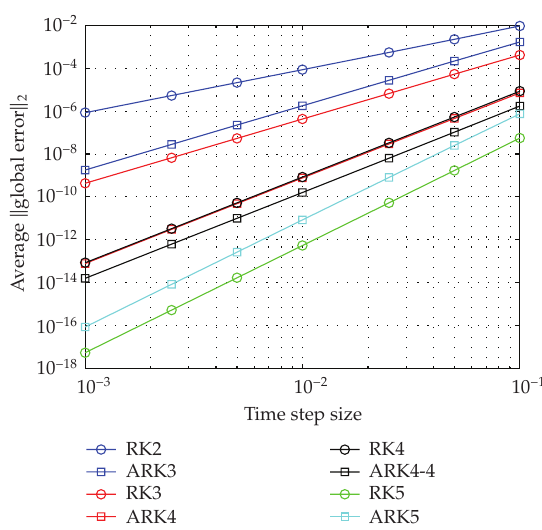
Figure 4: Accuracy plot for IVP-3 (cid:4) see caption of Figure 2 (cid:5) .